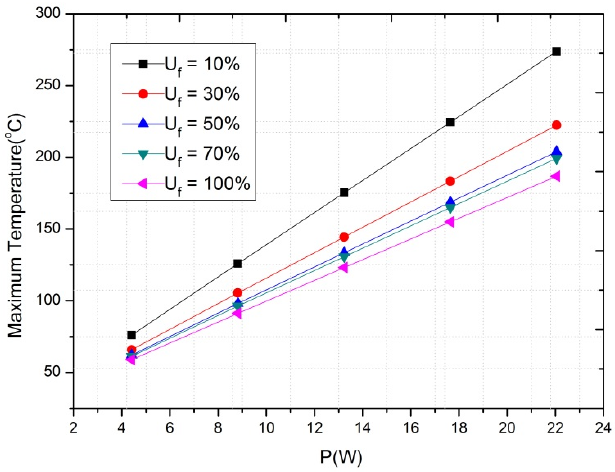
Figure 9. The effect of heating power on the highest temperature of TEG.